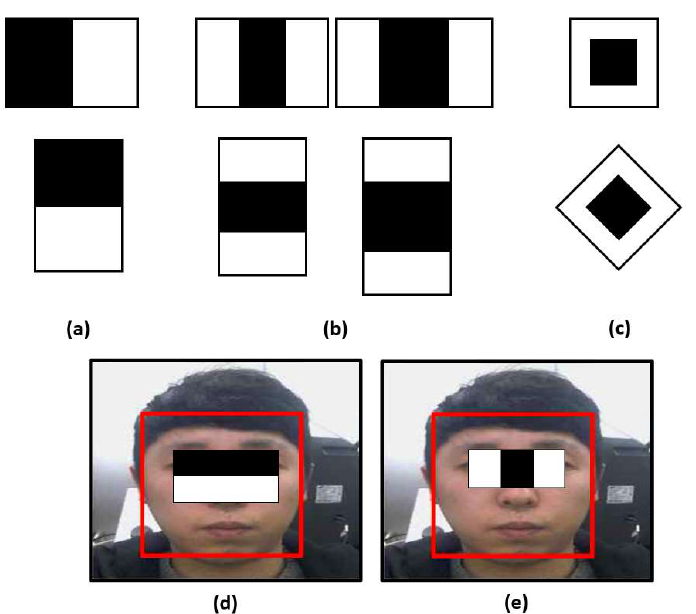
Figure 2. Expended set of Haar-like features: ( a ) edge features, ( b ) line features, ( c ) center-surround features. Face detection based on ( d ) the edge feature of Haar, ( e ) the line feature of Haar. X and Y coordinates of the detected face using the Haar feature were entered at 30 frames per second and the coordinate position was changed from frame to frame. X coordinates were unstably detected over time, as shown in Figure 3. This instability affected the cheek area’s coordinates based on plane coordinates, which hindered the extraction of color values from the identical area of each frame.